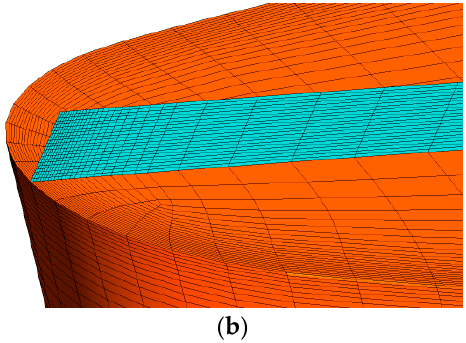
Figure 5. The mesh generation. ( a ) Assembly mesh [28]. ( b ) The tip clearance mesh.